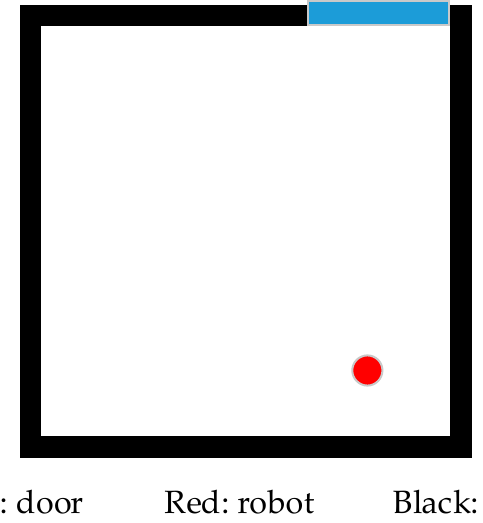
Figure 1. A square, symmetrical room.